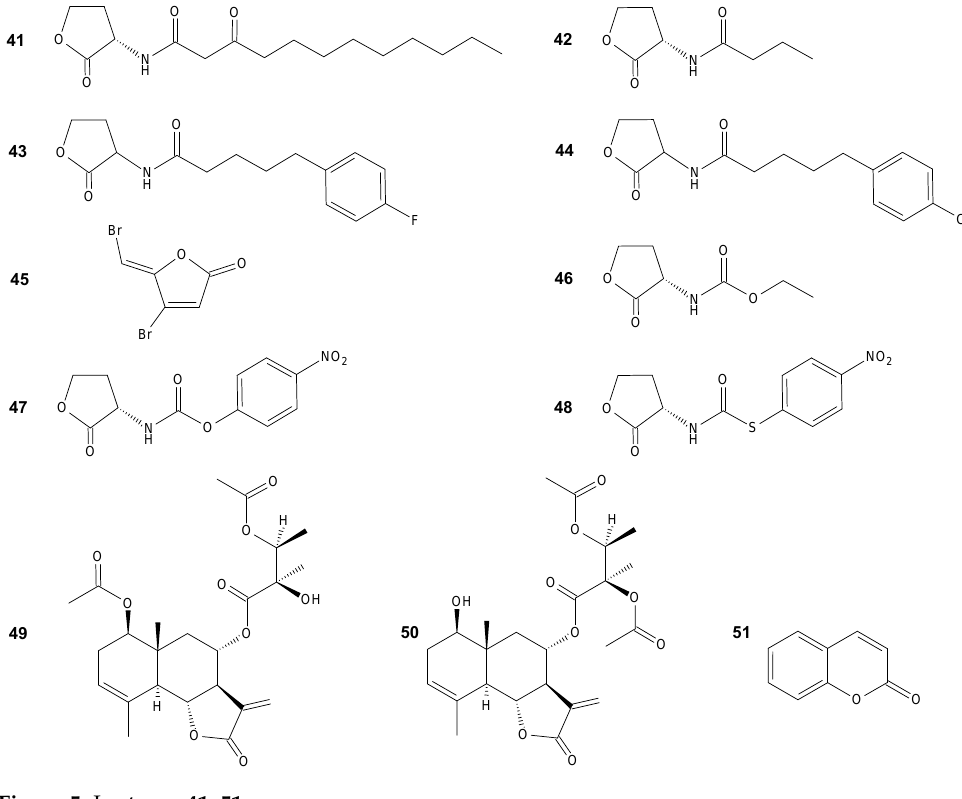
Figure 5. Lactones 41 – 51 .